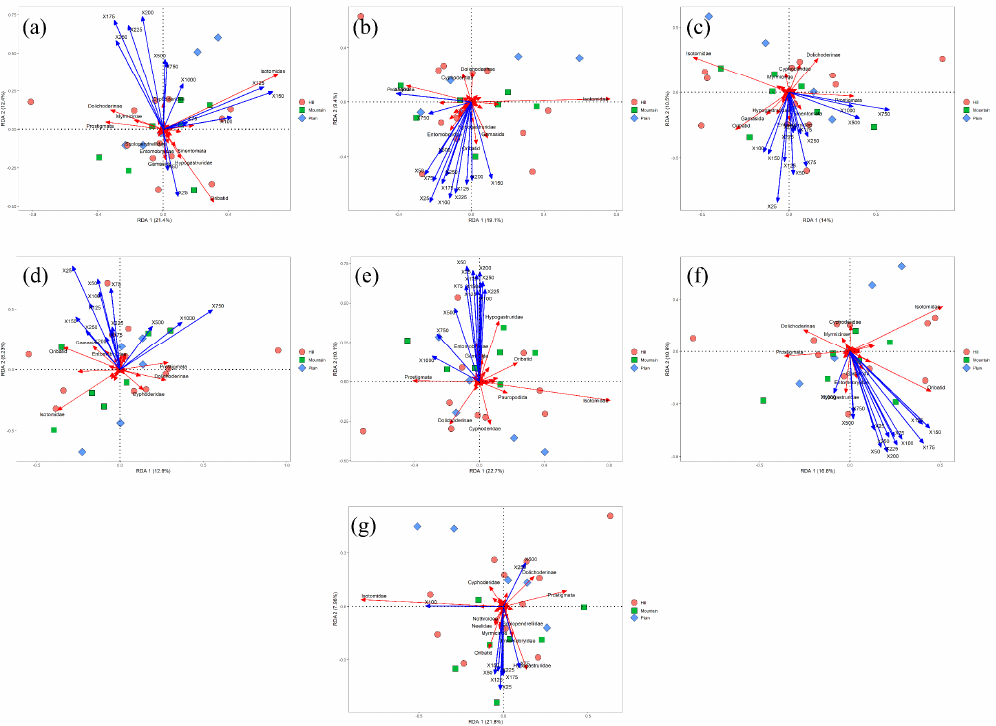
Figure A5. RDA analysis of landscape indices composition with soil fauna in different buffer zones.